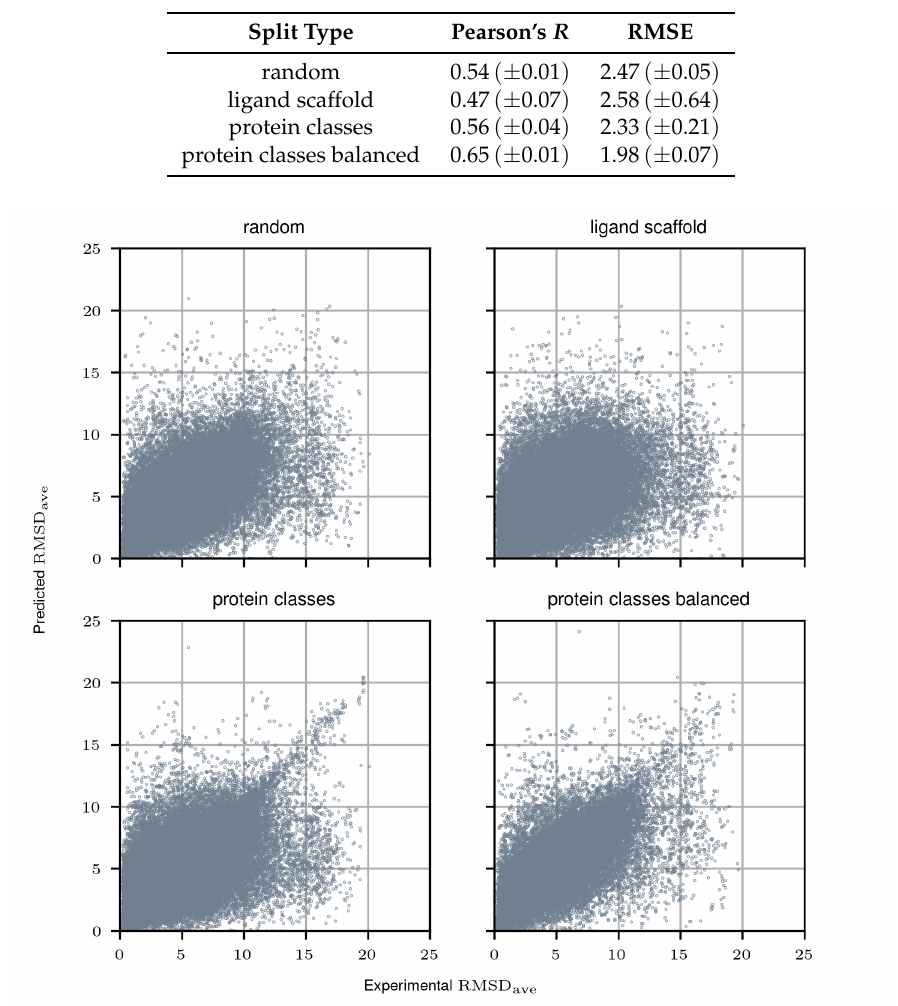
Figure 1. Ligand-centric RMSD ave evaluation merging all protocols and for all different types of proposed